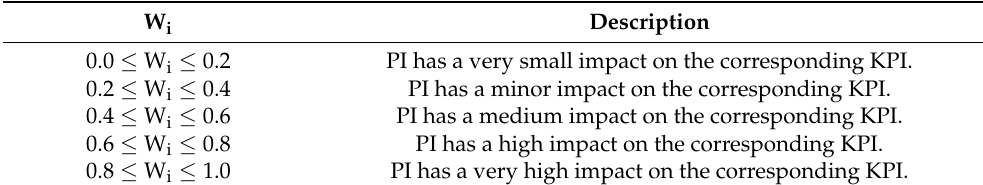
Table 6. Description of weight (W i ) of a performance indicator (PI i ) related to the corresponding key performance indicator